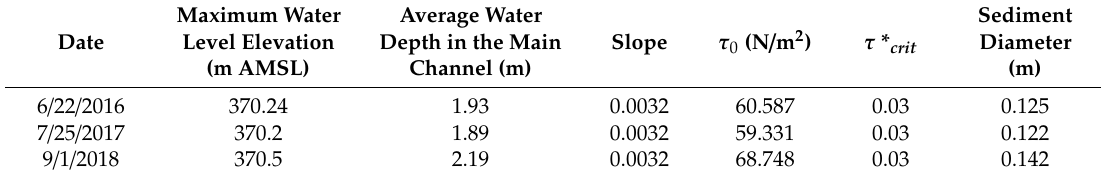
Table 3. Maximum particle size moved after breakup—Sagavanirktok River near MP318 (DSS4).